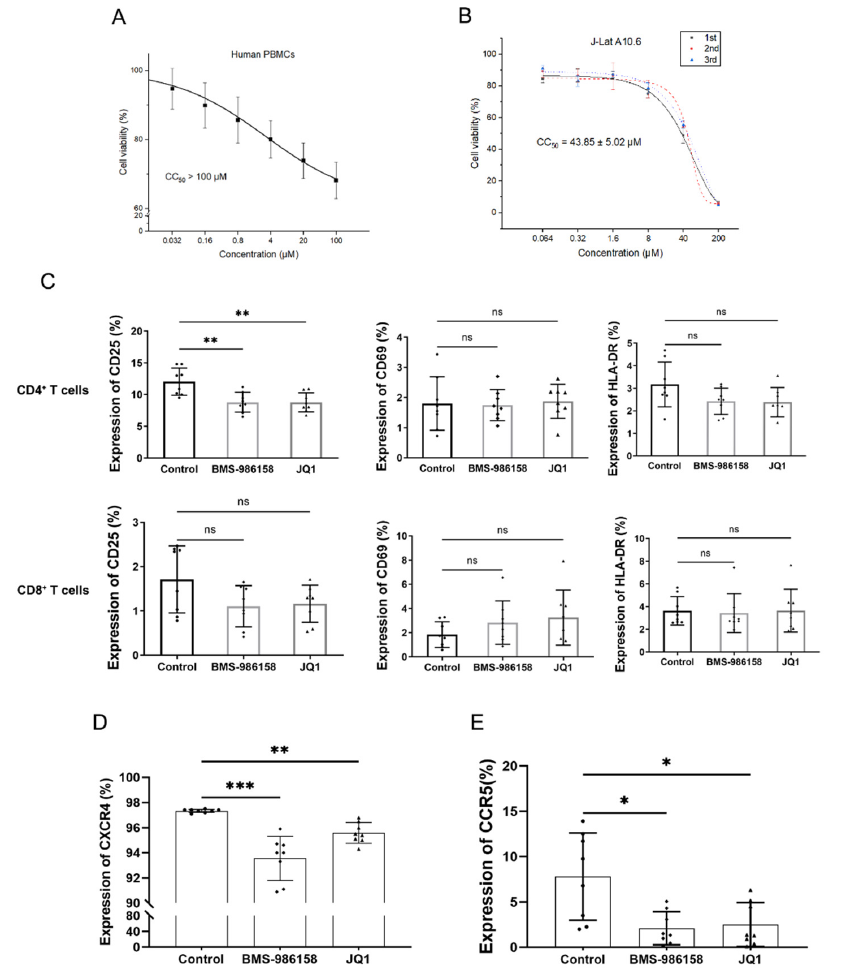
Figure 2. Toxicity of BMS-986158. ( A , B ) Cytotoxicity of BMS-986158 in PBMCs and J-Lat cells. PBMCs and J-Lat cells were treated with gradient-diluted BMS-986158 for 48 h and cell viability was measured by MTT. Data represent the mean ± SD of three independent experiments. ( C ) Effect of BMS-986158 on T cell activation. PBMCs from eight donors were treated with BMS-986158 or JQ1 for 48 h and stained with anti-CD4, anti-CD8, anti-CD25, anti-CD69, and anti-HLA-DR antibodies to measure expression by flow cytometry. ( D , E ) Effect of BMS-986158 on expression of HIV-1 co-receptors CXCR4 and CCR5. CD4 + T cells in PBMCs from eight donors were treated with BMS-986158 or JQ1 for 48 h and stained with anti-CXCR4 or anti-CCR5 antibodies to measure expression by flow cytometry. Single independent experiment was including for each donor ( n = 8), data represent the mean ± SD. The statistically significant difference between control and BMS-986158, and control and JQ1 treatment group were analyzed using one-way ANOVA followed by Dunnett’s multiple comparisons test ( C ) and Dunnett’s T3 multiple comparisons test ( D , E ). (* p < 0.05; ** p < 0.01; *** p < 0.001; ns, no